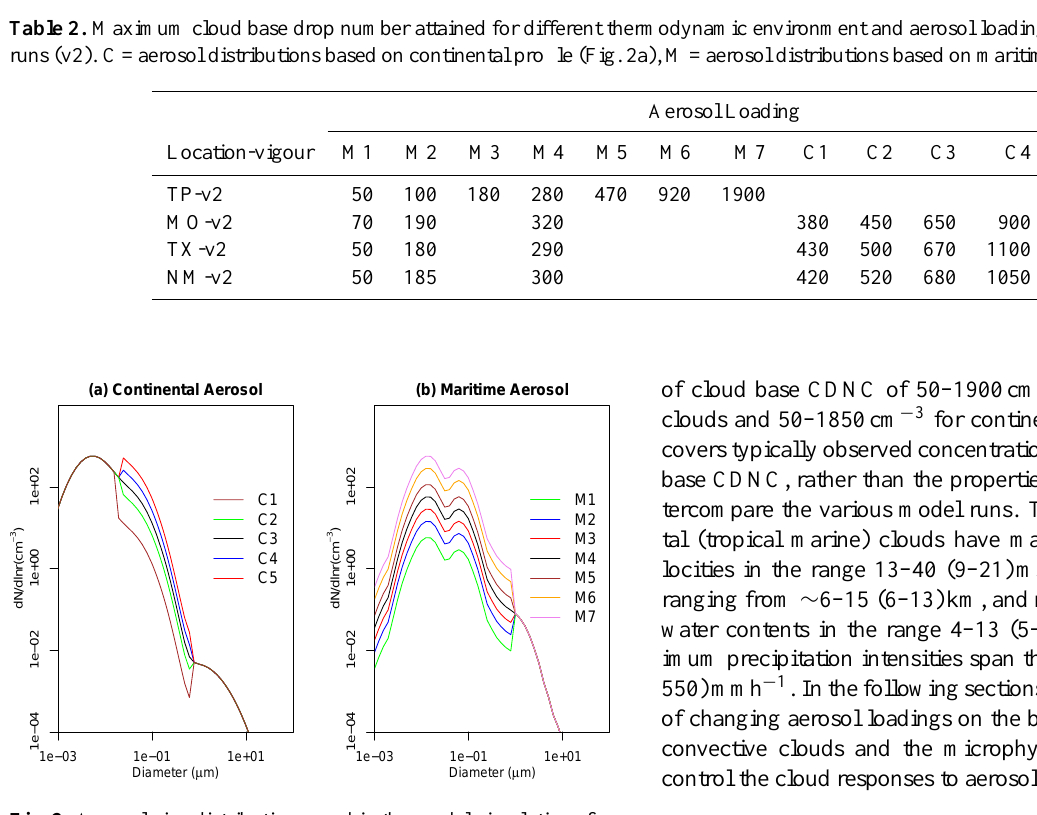
Fig. 2. Aerosol size distributions used in the model simulations for (a) continental clouds and (b) tropical marine